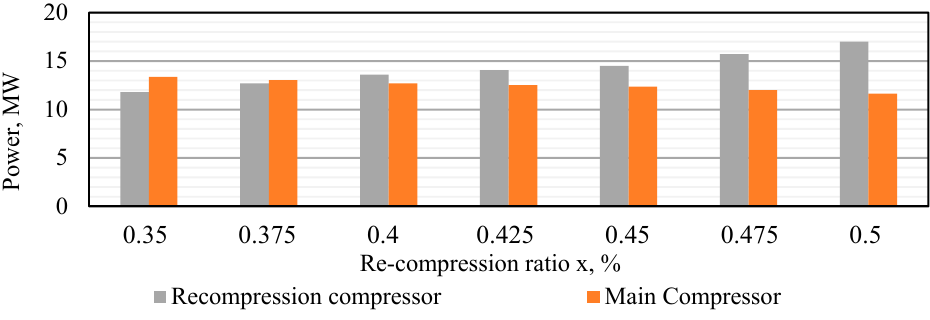
Figure 7. Technical performance comparison of recompression Brayton cycle.